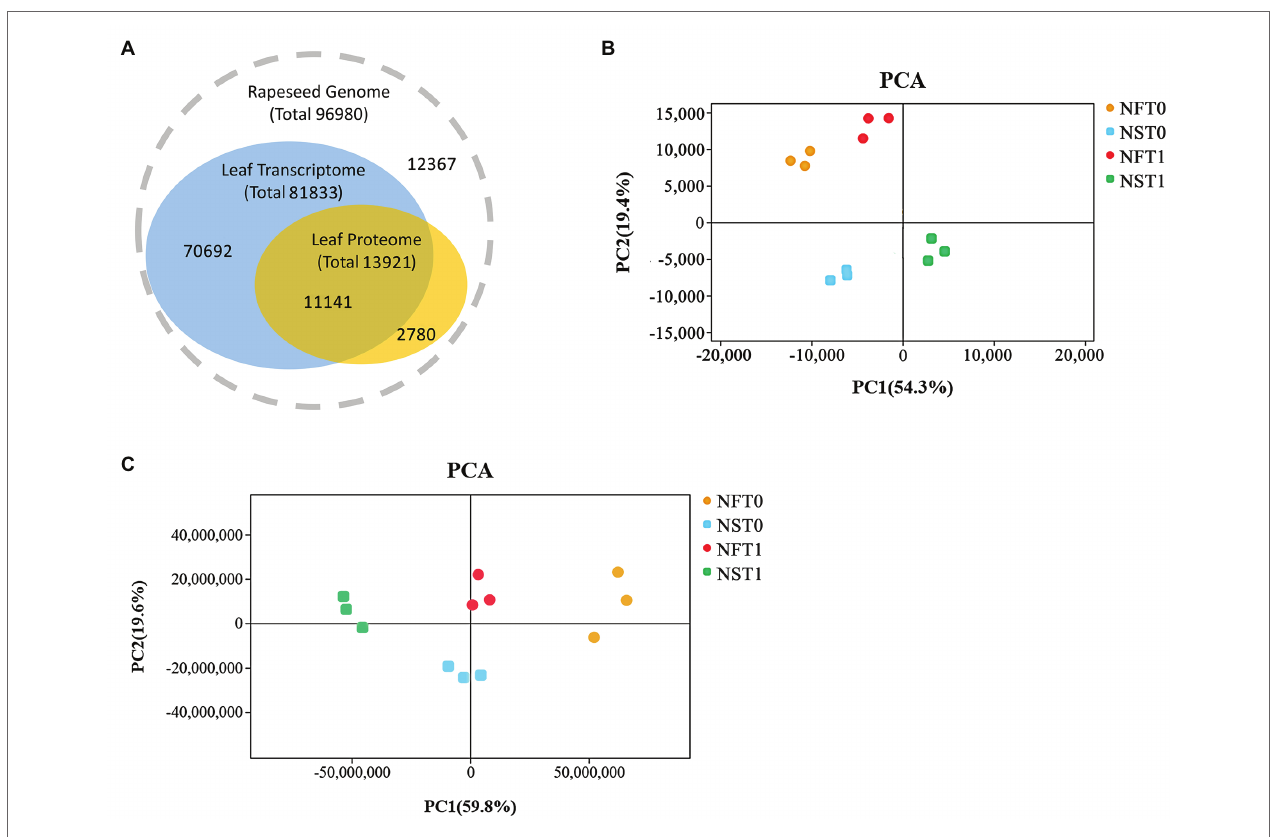
FIGURE 3 | The overview of transcriptome and proteome in rapeseed cultivars NF and NS. (A) Consistency between the identified transcripts and proteins in the leaves of both cultivars. (B) Principal component analysis (PCA) of detected genes in RNA sequencing. (C) PCA of detected proteins in data-independent acquisition